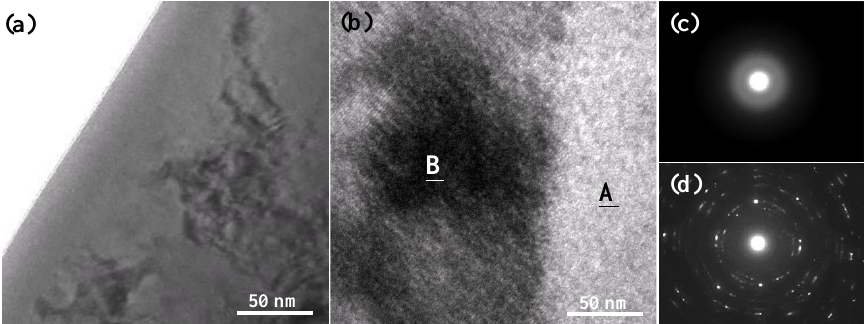
Figure 4. TEM micrographs of the unmodified 316L BSS and anodized 316L BSS specimens. ( a ) Bright-field image of the unmodified 316L BSS specimen, ( b ) bright-field image of the anodized 316L BSS specimen at 5 V for 5 min, ( c ) selected-area diffraction pattern taken from the area A in ( b ), and ( d ) selected-area diffraction pattern taken from the area B in ( b ).